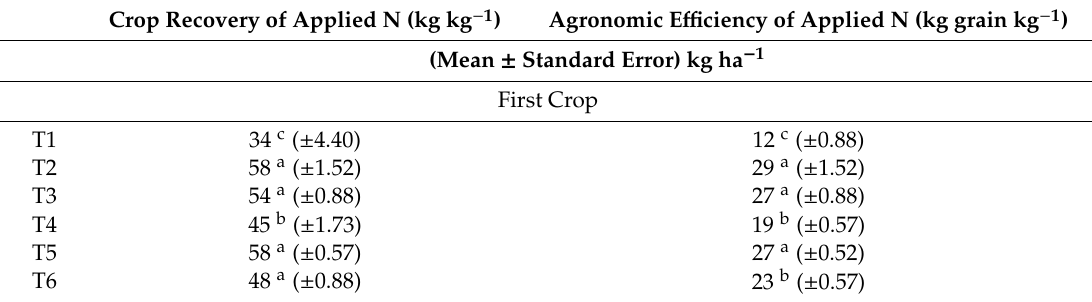
Table 4. Two nitrogen use efficiency indices of applied N at harvest for both maize crops. Crop Recovery of Applied N (kg kg − 1 )